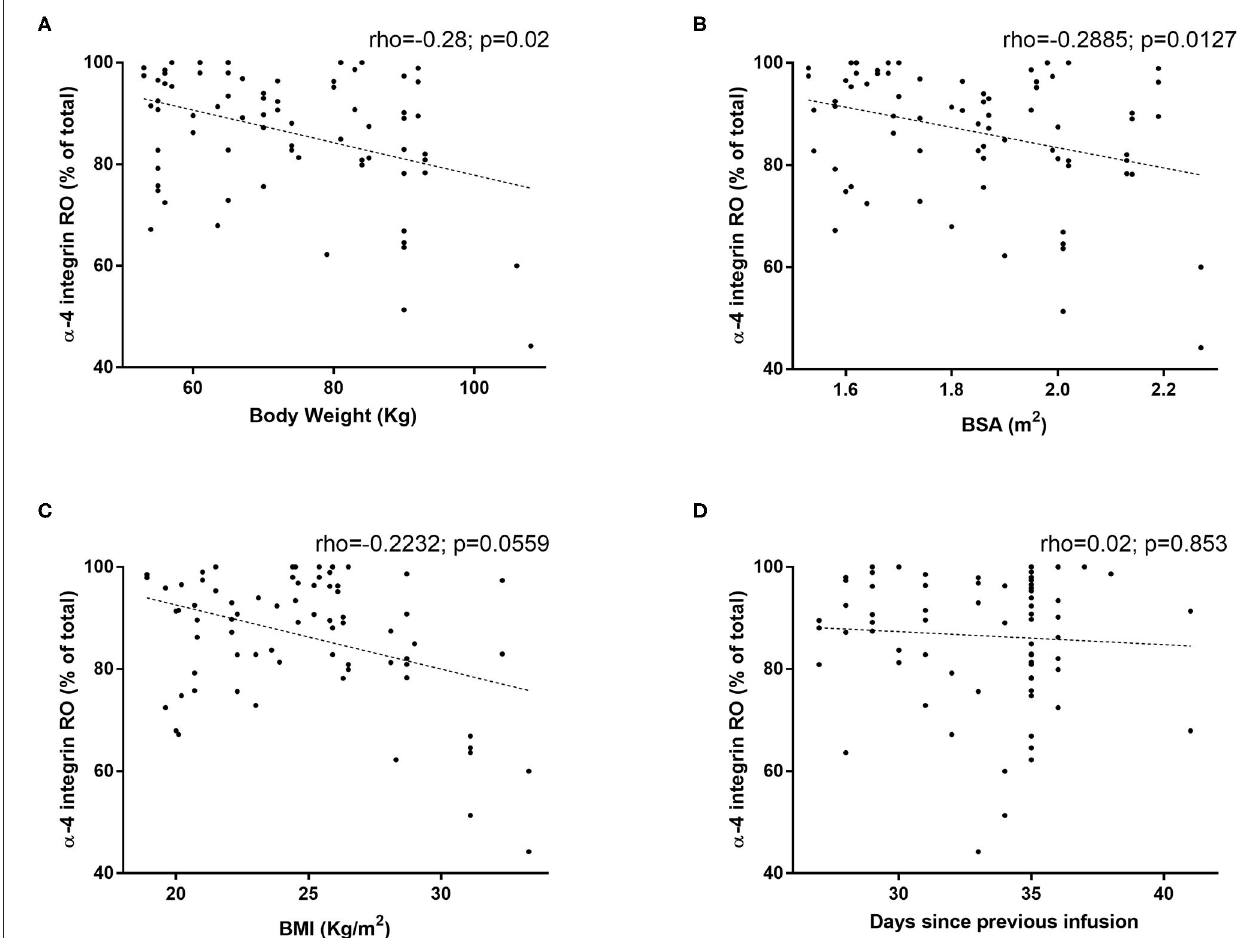
FIGURE 2 | Correlation of receptor occupancy of α 4-integrin by natalizumab to (A) body weight, (B) Body Surface Area (BSA), (C) Body Mass Index (BMI), and (D) scheme doses. The receptor occupancy of natalizumab was measured by flow cytometry, with an anti-human IgG4-PE, by revealing the binding of natalizumab to the surface of the lymphocytes in 74 samples from 32 patients. Spearman’s correlation (rho) was used for association analysis of quantitative variables.